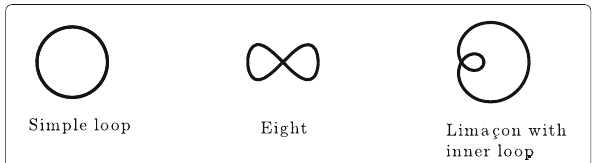
Fig. 10 Schematic closed planar curves: non intersecting curve, eight curve and limaçon curve